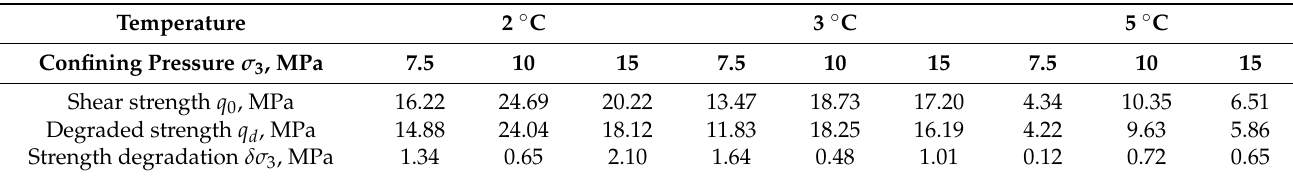
Table 1. Strength degradation of MHBS.